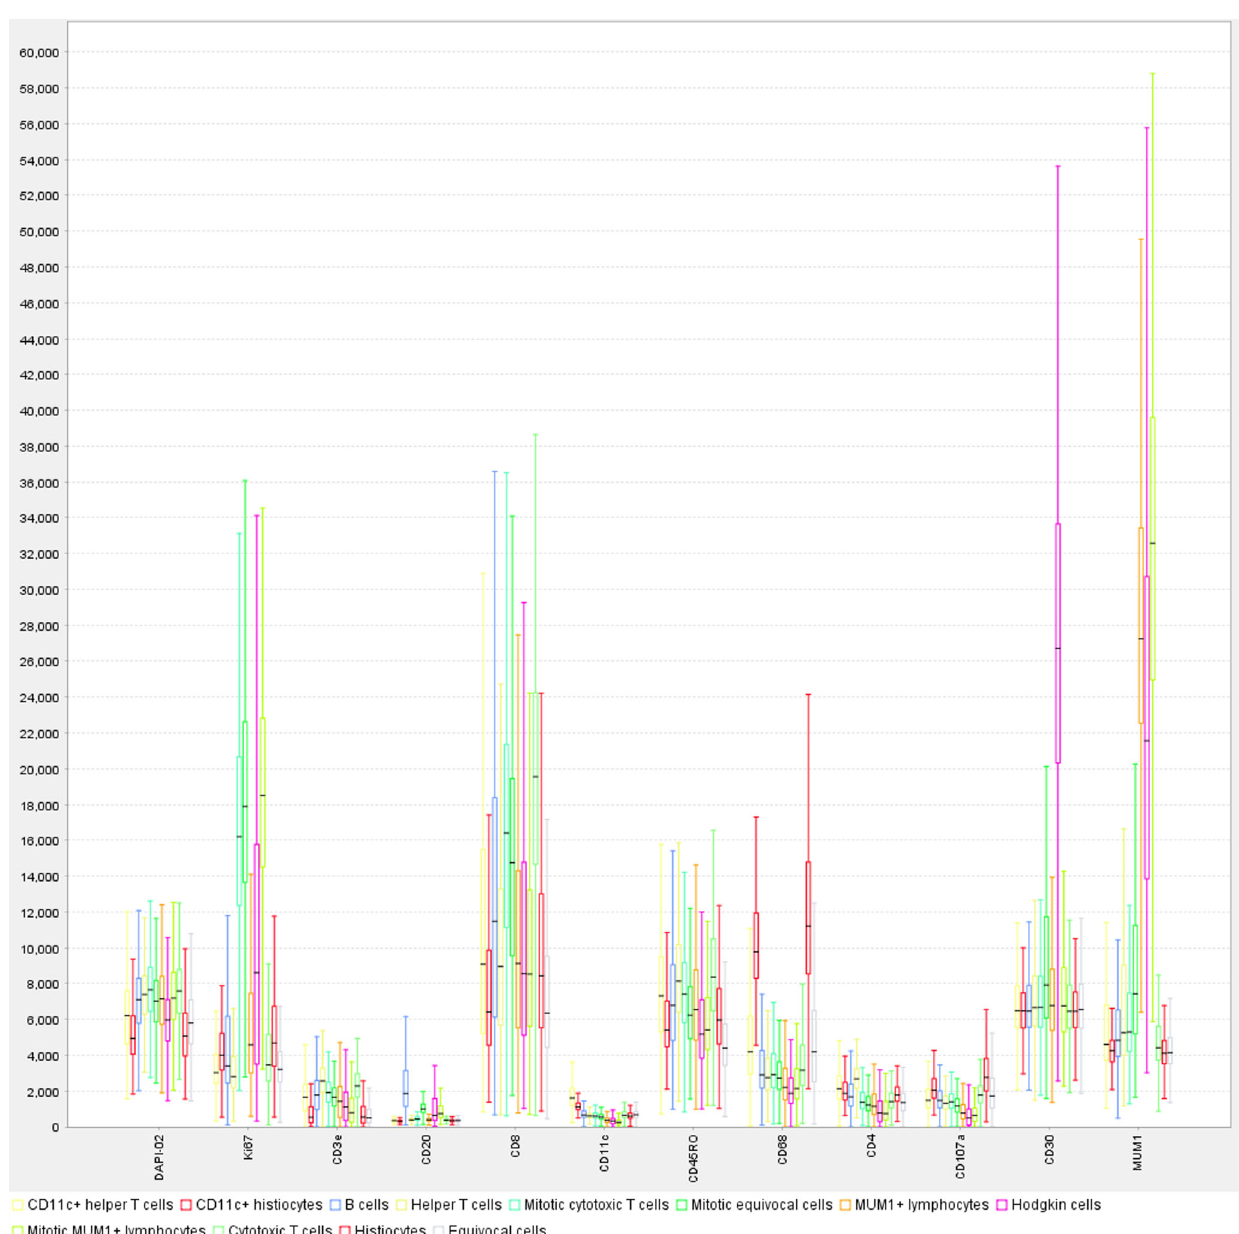
Fig. 5 Box plot presentation of staining intensities for cell types in tissue involved by classic Hodgkin lymphoma. Of note are the very strong relative intensities of the CD30 + Hodgkin cells and MUM1 + cells (Hodgkin cells and some lymphocytes), attributed to tyramide signal ampli fi cation. Boxes indicate upper and lower quartiles; lines extending beyond the boxes (whiskers) demonstrate additional variability above and below the upper and lower quartiles. See also Fig. 3 and Supplementary Figs. 10,